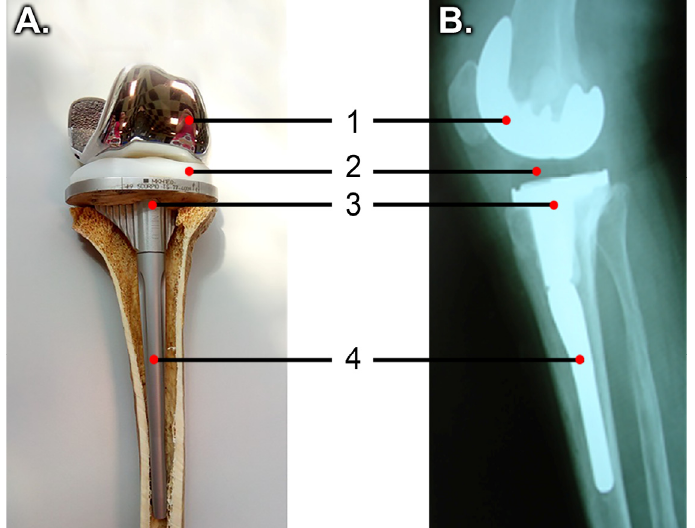
Figure 1. Knee arthroplasty: ( A ) Tibial bone with prosthesis, laboratory model, ( B ) Postoperative radiograph ((1) femoral metal implant, (2) polyethylene spacer, (3) tibial metal implant, and (4) tibial stem extension).